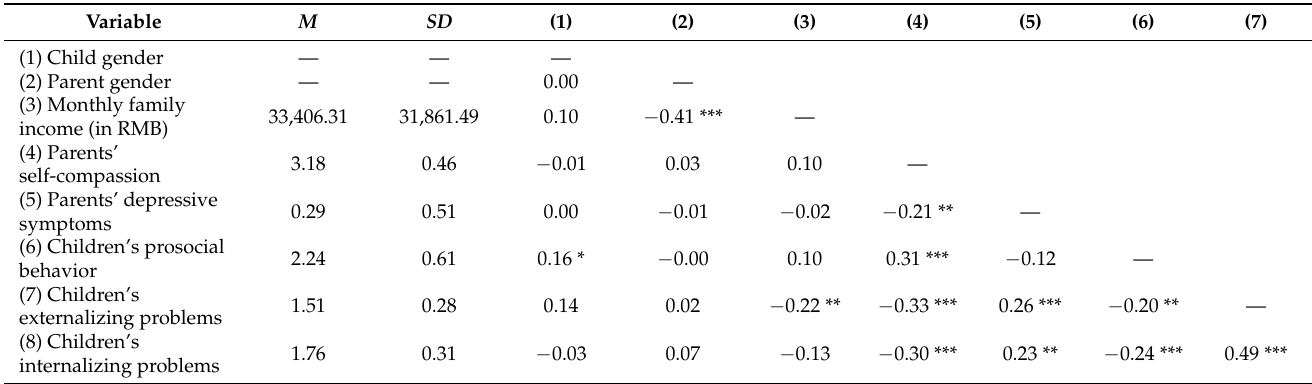
Table 1. Means, standard deviations, and zero-order correlations of the variables under